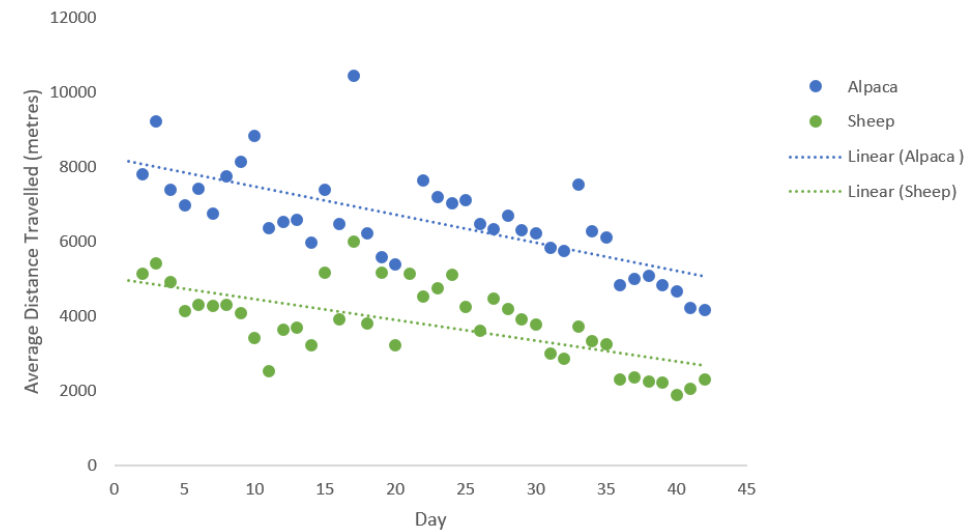
Figure 3. Average daily distances (m) travelled and trend over time by alpacas and lambing ewes over the 41-day testing period.